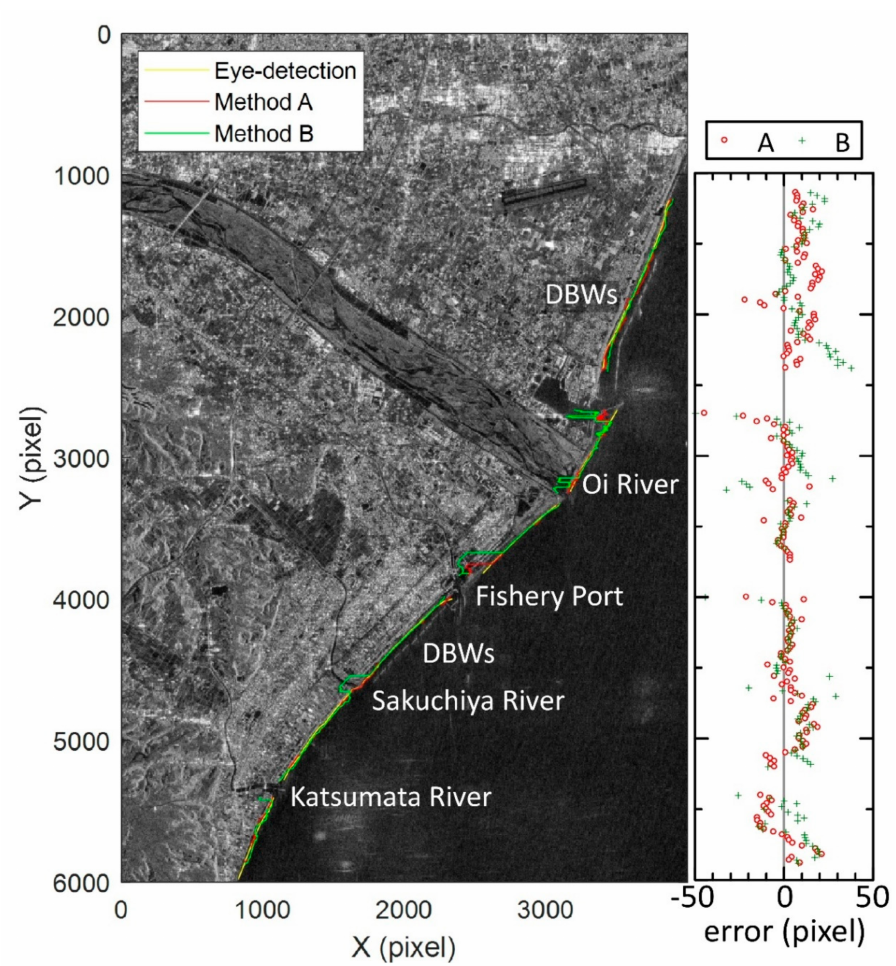
Figure 13. Grayscale image of the Suruga coast with extracted shorelines ( left ) and differences in the shoreline position between that extracted from eye-detection and the others from the NN models ( right